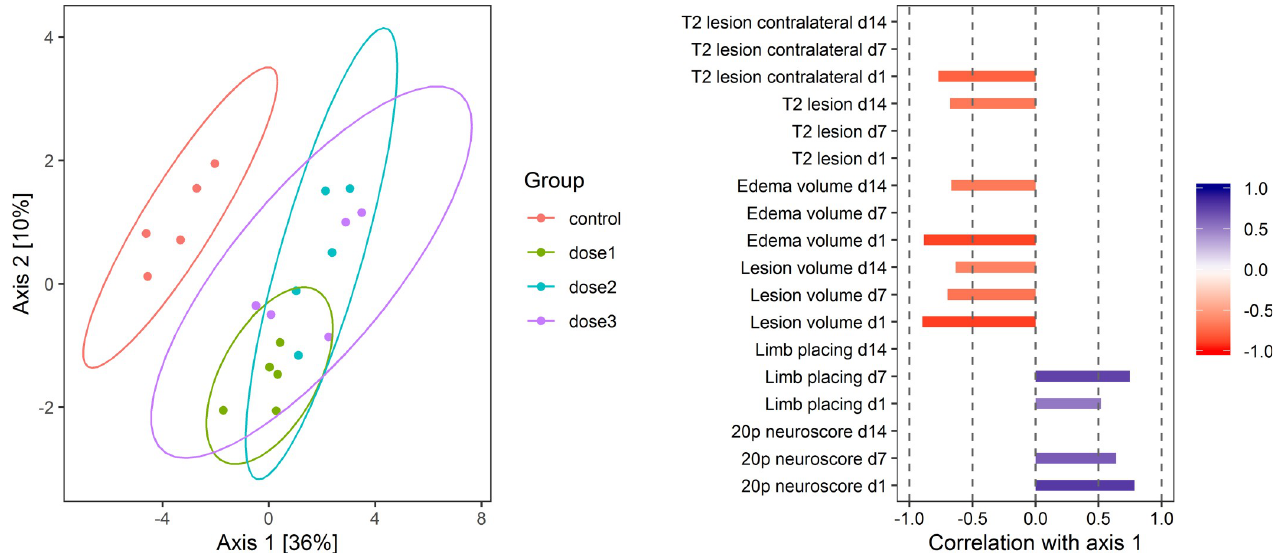
Fig 7. Partial least squares discriminant analysis (PLS-DA) to identify treatment effect patterns. We simulated a data set with 5 measurements per group and huge treatment effects for 9 randomly selected endpoints out of the 18 variables in the data set. The control group was separated from the treatment groups along the first multivariate dimension in the PLS-DA analysis We calculated the correlation of the original variables with this dimension to identify which original endpoints explained the multivariate pattern. Correlations with an absolute value below 0.5 were set to 0 in order to filter out unimportant variables. All 9 variables with simulated treatment effects were significantly correlated with the first multivariate axis. Two additional variables without simulated treatment effects (lesion volume at day 14 and T2 lesion at day 14) were also significantly correlated with the first multivariate axis.